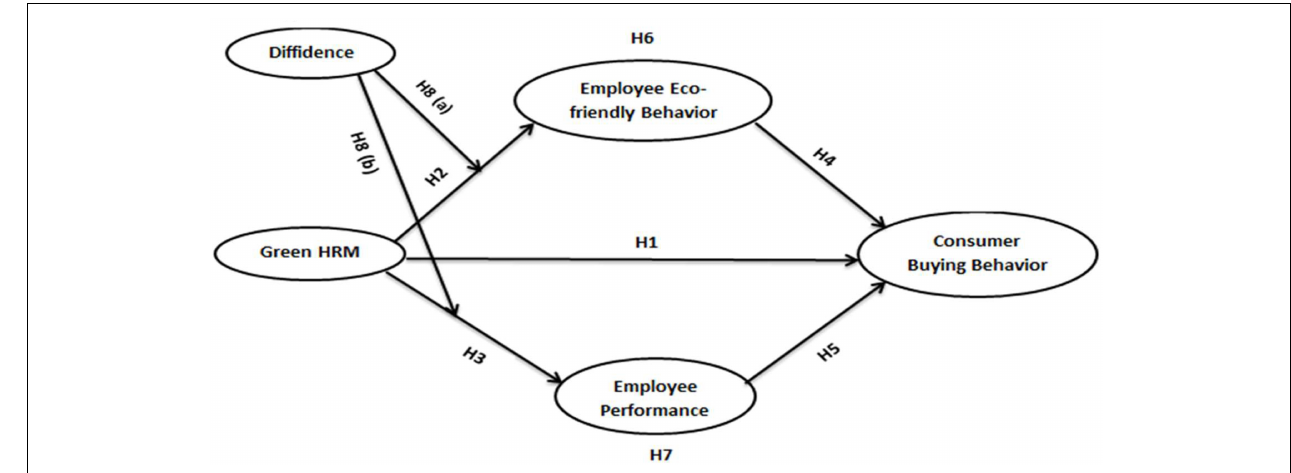
FIGURE 1 | Conceptual